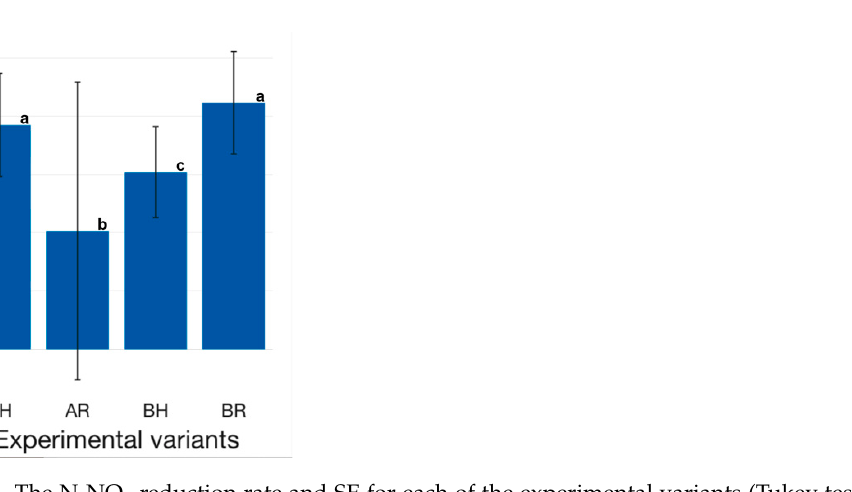
letter reveal not significant statistical differences ( p > 0.05).